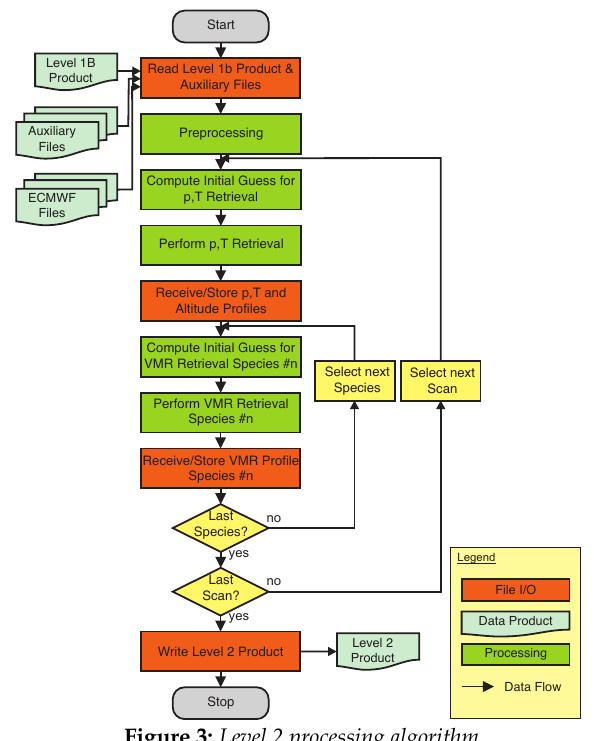
Figure 3: Level 2 processing